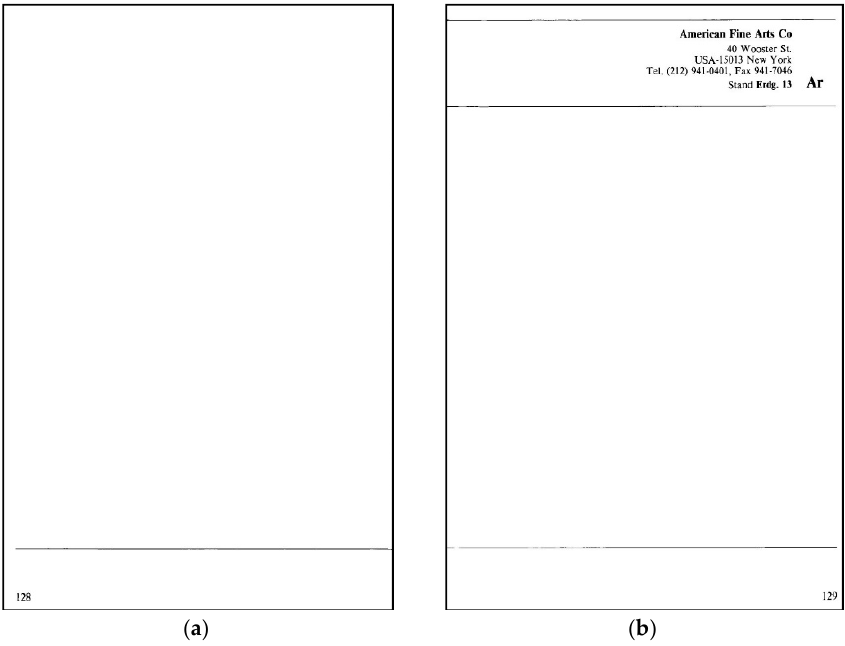
Figure 7. Catalogue entry from American Fine Arts Co , New York. ( a ) left side, ( b ) right side (Messe- und Ausstellungs-Ges.m.b.H. 1989, pp. 128f).